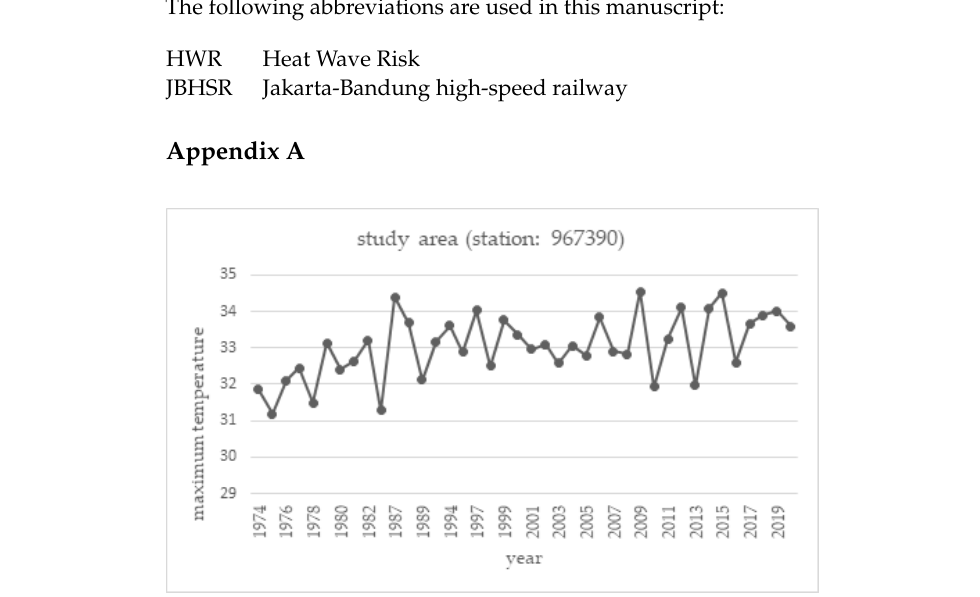
Figure A1. Average maximum temperature in September along the Jakarta-Bandung high-speed railway.